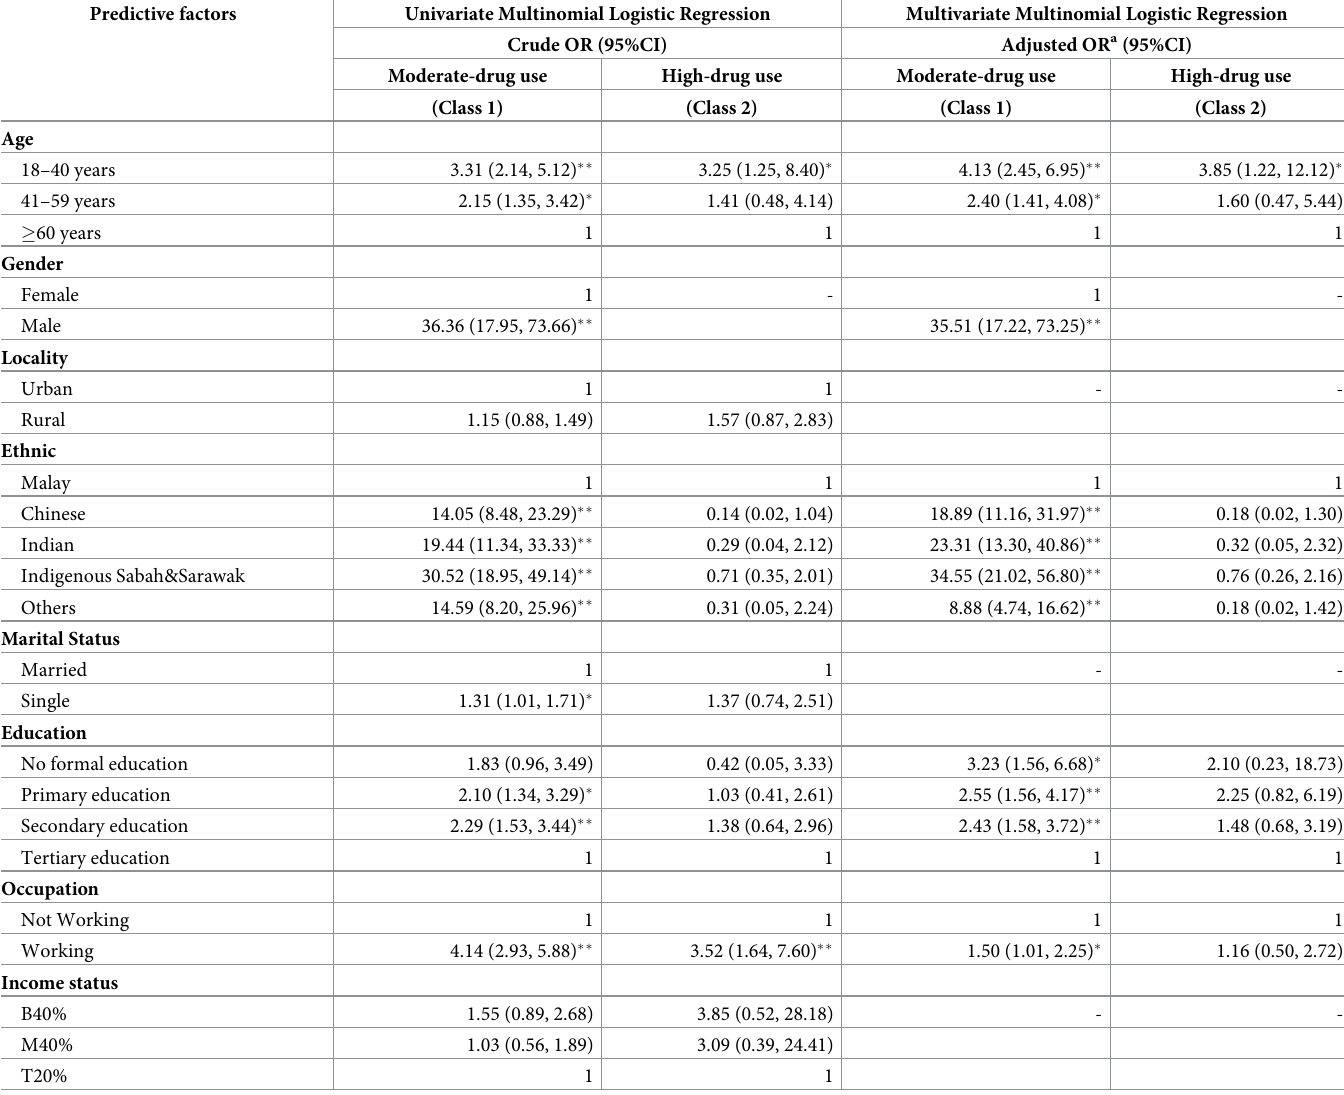
Table 5. Factors associated with polysubstance use among Malaysian adults from multivariate multinomial logistic regression analysis (n = 10,464). Predictive